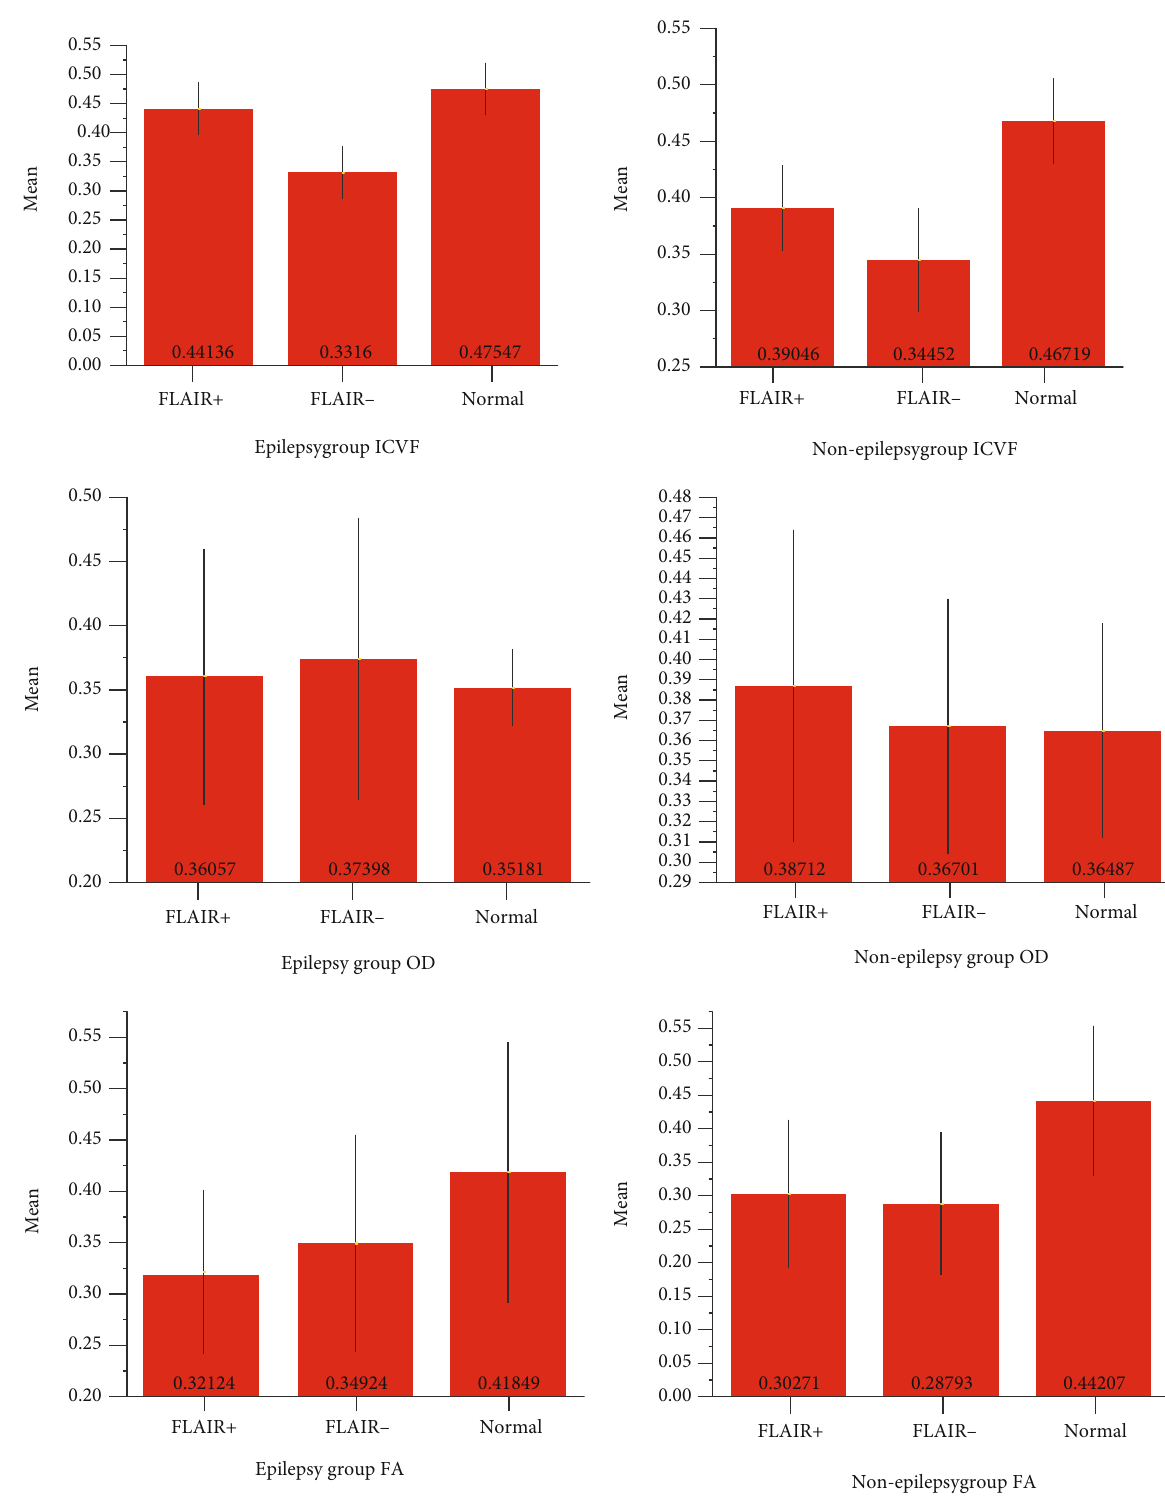
Figure 6: (a) ICVF: FLAIR hyperintense part: the FLAIR hyperintense part of the epilepsy group is signi fi cantly higher; epilepsy group: the FLAIR(+) part is signi fi cantly higher than the FLAIR(-) part but is signi fi cantly lower than the normal part. (b) OD. (c) FA: the normal part is signi fi cantly higher than the FLAIR(+) part and FLAIR(-) part in both the epilepsy and nonepilepsy groups, but there is no signi fi cant di ff erence between the FLAIR(+) part and the FLAIR(-) part. (d) ADC: the FLAIR hyperintense part and FLAIR hypointense part are signi fi cantly higher than the normal part in both the epilepsy and nonepilepsy